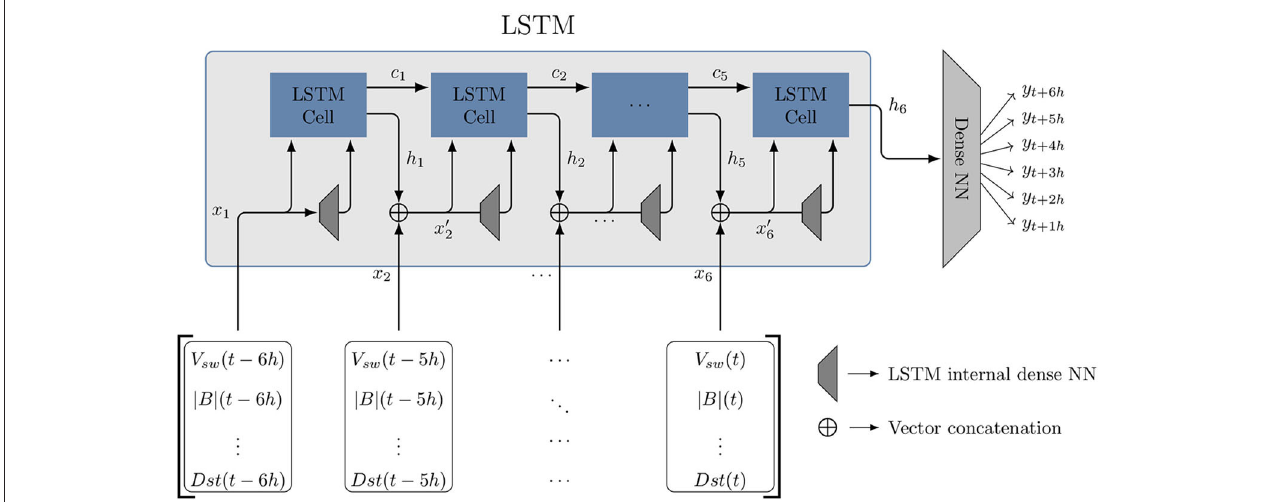
FIGURE 1 | The architecture of the LSTM-NN model. The time series input is first given to an LSTM, which iteratively uses each time step of the input x t , together with the previous hidden state h t , to update the memory state c t and construct a new hidden state h t . The LSTM cell requires as input the concatenated vector from x t − 1 and h t , together with the output of the LSTMs internal dense NN taking that same vector as input. The final hidden state of the LSTM is given to a dense neural − 1 network, who transforms it to a six-dimensional output vector Y